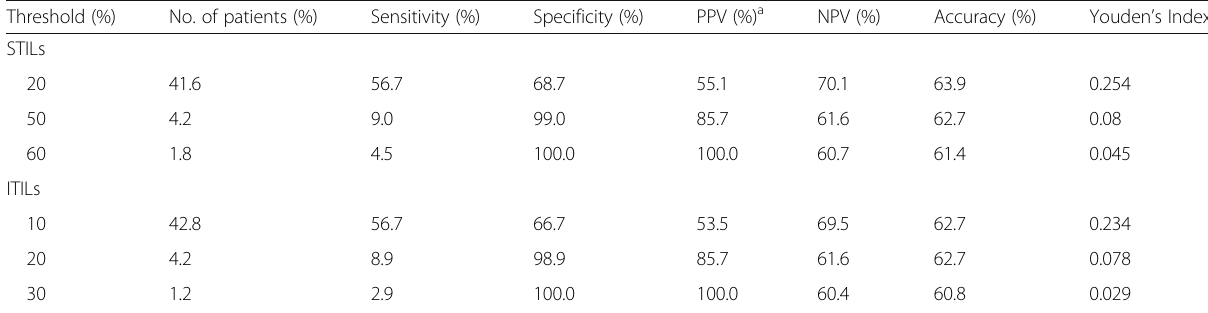
Table 5 Comparisons between different thresholds of sTILs and iTILs Threshold (%) No. of patients